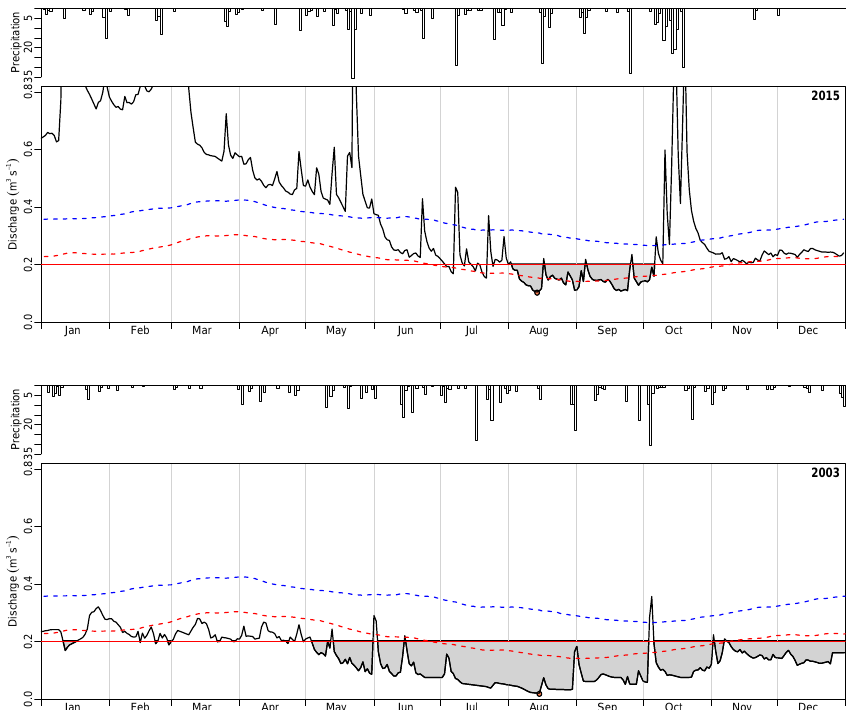
Figure 4. Hydrograph of gauge Altschlaining at the river Tauchenbach in Austria (black line, large panels). Preconditions in 2015 (a) were much wetter than in 2003 (b) . The grey polygon indicates the maximum annual low flow event below the annual threshold Q 80 . The area of the polygon corresponds to the deficit volume, and its length (between onset and termination date) is the duration of the event. Dashed lines show seasonal varying thresholds Q 80s (red) and Q 50s (blue), corresponding to smoothed (30-day moving average) daily flow quantiles with exceedance probability 0.8 and 0.5. These lines are used to benchmark long-term average and dry seasonal conditions, respectively. Precipitation (daily sums in millimeters, mm) shown in the smaller panels above the